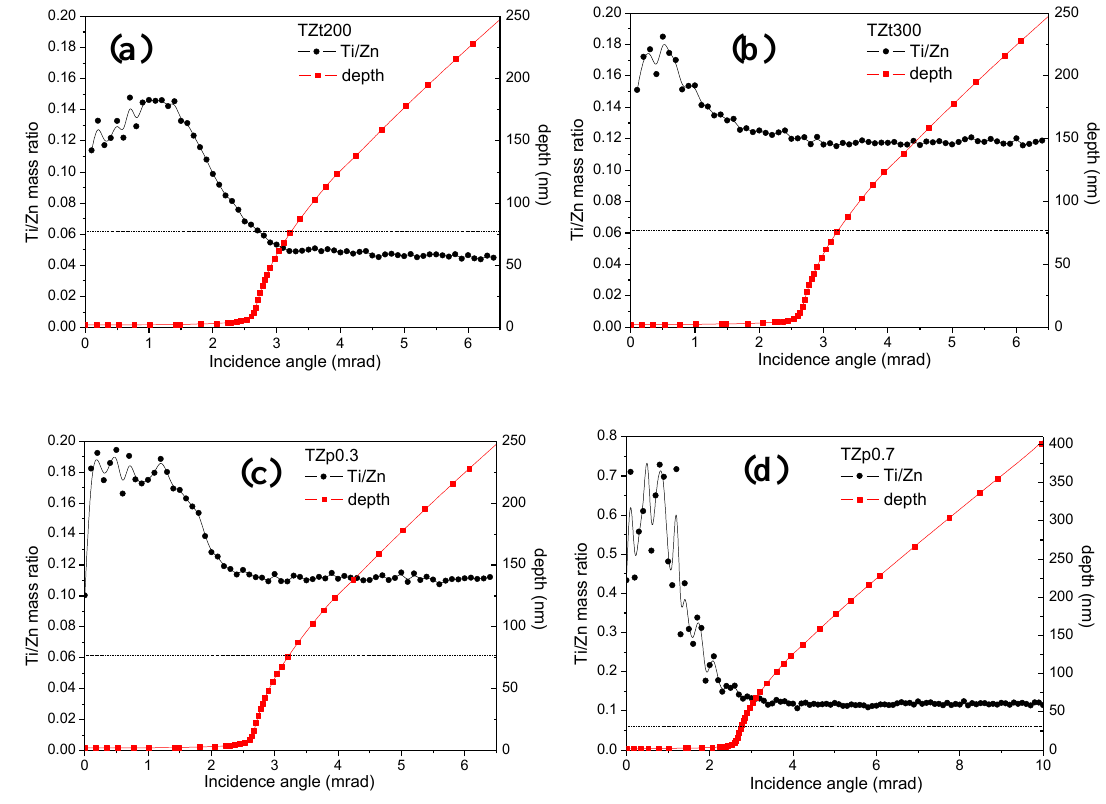
Figure 3. Depth profile of Ti/Zn mass ratios (black circles) and theoretical TZO depth curve (red squares) versus incidence angle of TZO thin films with different annealing conditions. The dotted line represents the theoretical Ti/Zn expected ratio. ( a ) TA at 200 °C, ( b ) TA at 300 °C, ( c ) MwPA at 0.3 mbar and ( d ) MwPA at 0.7 mbar.